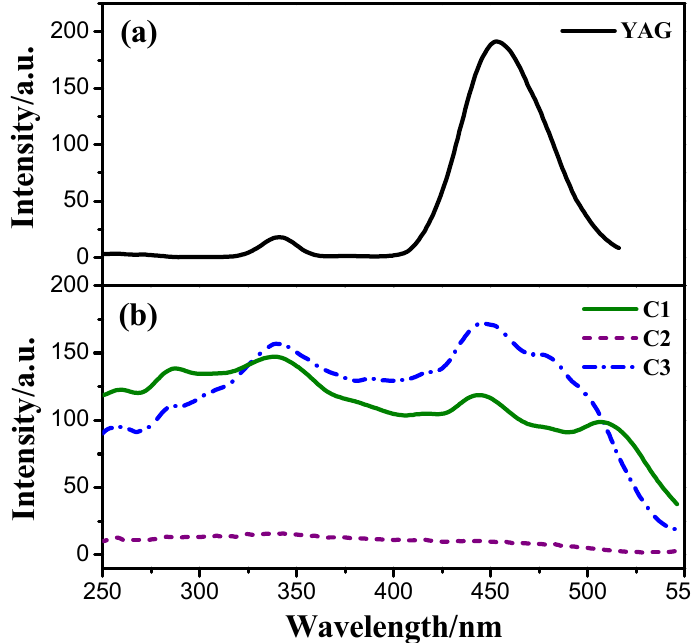
Figure 4. Excitation spectra ( λ em = 565 nm) of YAG ( a ) and the cationic iridium(III) complexes ( b ) powders.